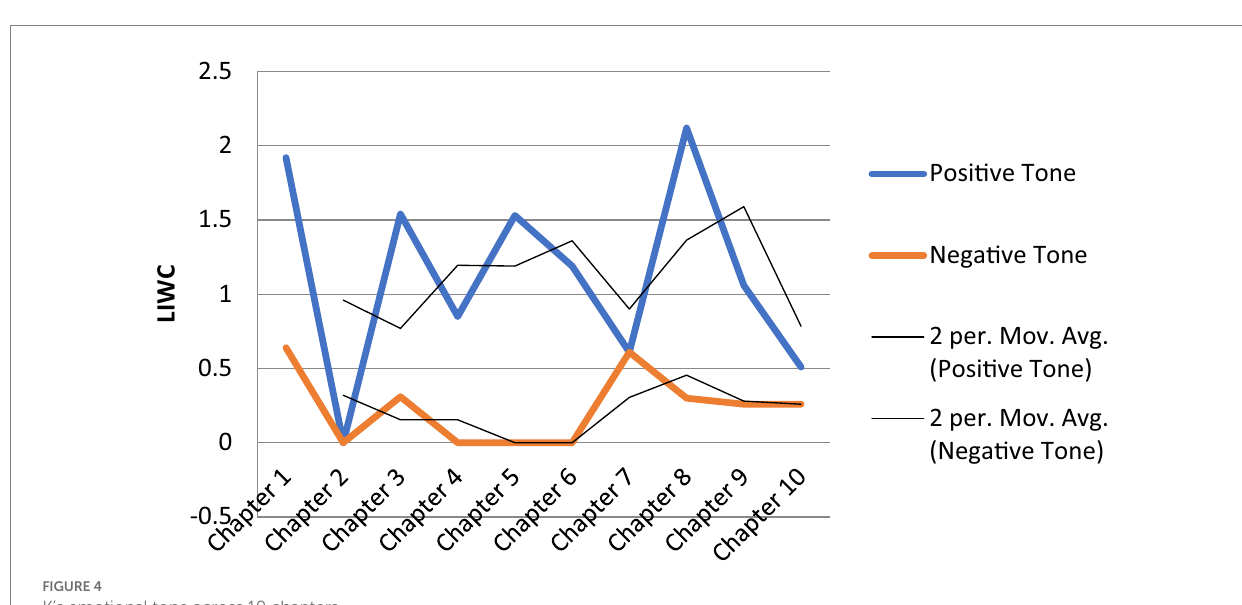
FIGURE 4 K’s emotional tone across 10